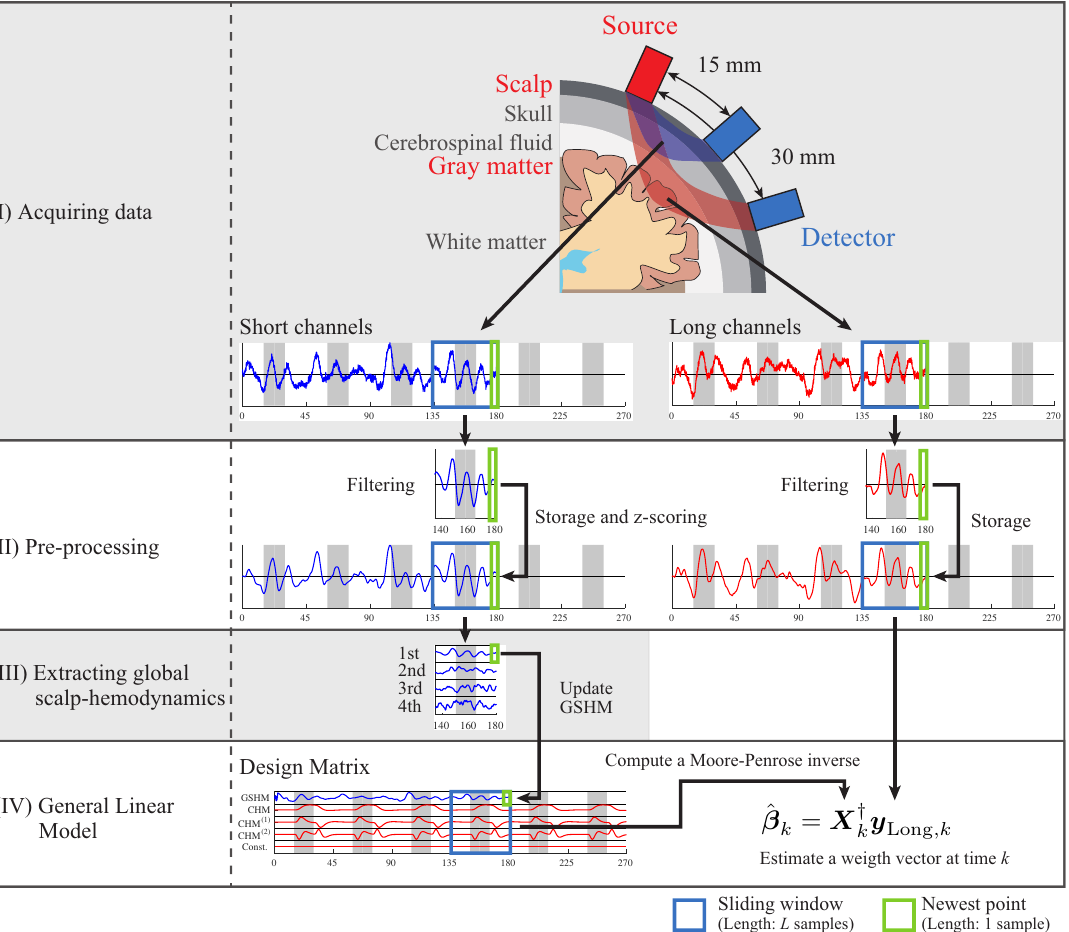
Figure 2. Flow of signal processing of proposed method, rt-ShortPCA general linear model (GLM). PCA: principal component analysis ; CHM: cerebral-hemodynamics model ; GSHM: global scalp-hemodynamics